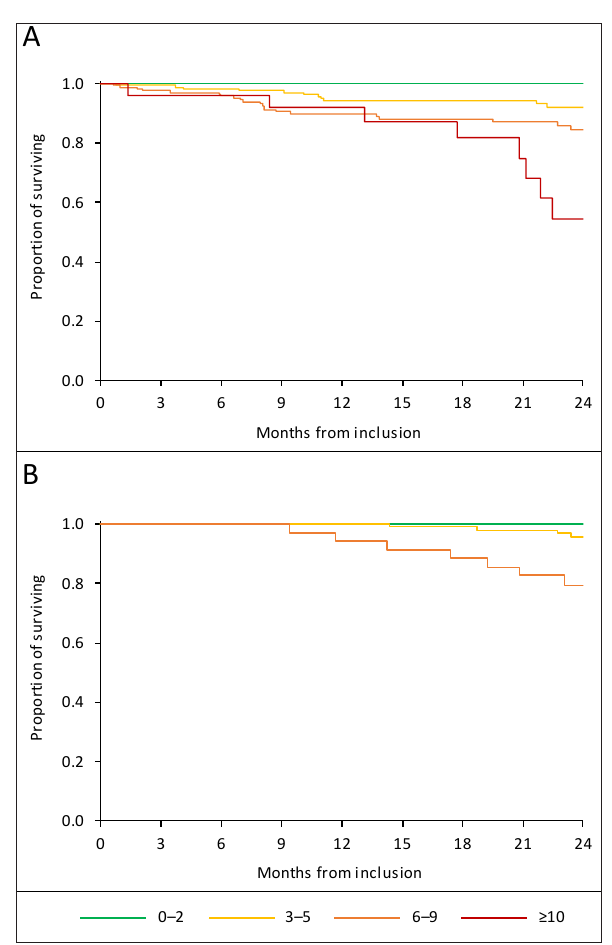
Fig. 1. Long-term survival according to the CADOT index (comparison of the derivation - CZ (A) and validation - NL (B) cohorts). CZ – Czech Republic; NL – Netherlands